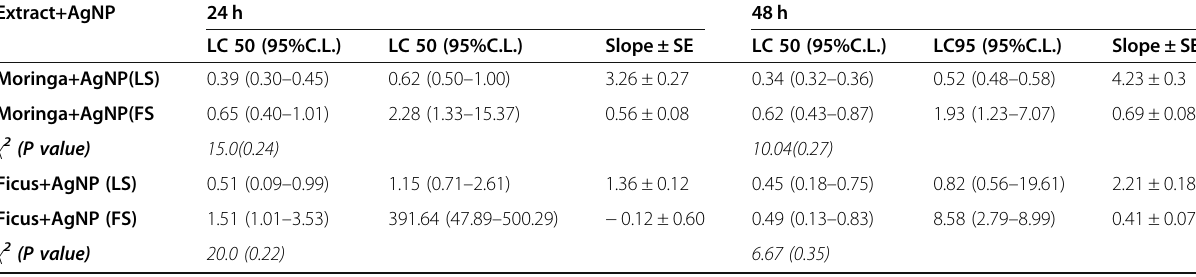
Table 1 Larvicidal toxicity of synthesized (AgNPs) against field and laboratory strains of Anopheles gambiae Extract+AgNP 24 h